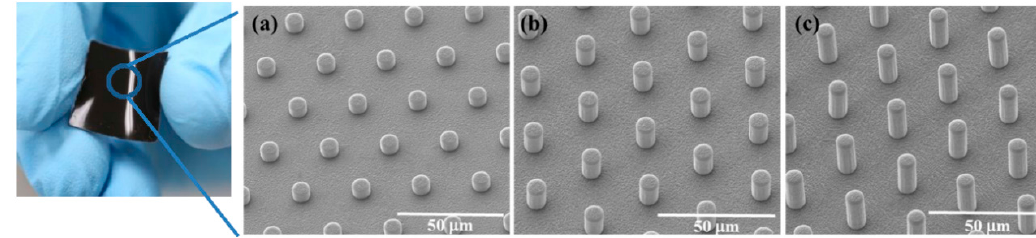
Figure 3. Picture of the fabricated MWCNT/PDMS film (20 mm × 20 mm) and FESEM images of ( a ) 5 μ m; ( b ) 10 μ m and ( c ) 20 μ m high micropillars on MWCNT/PDMS films.